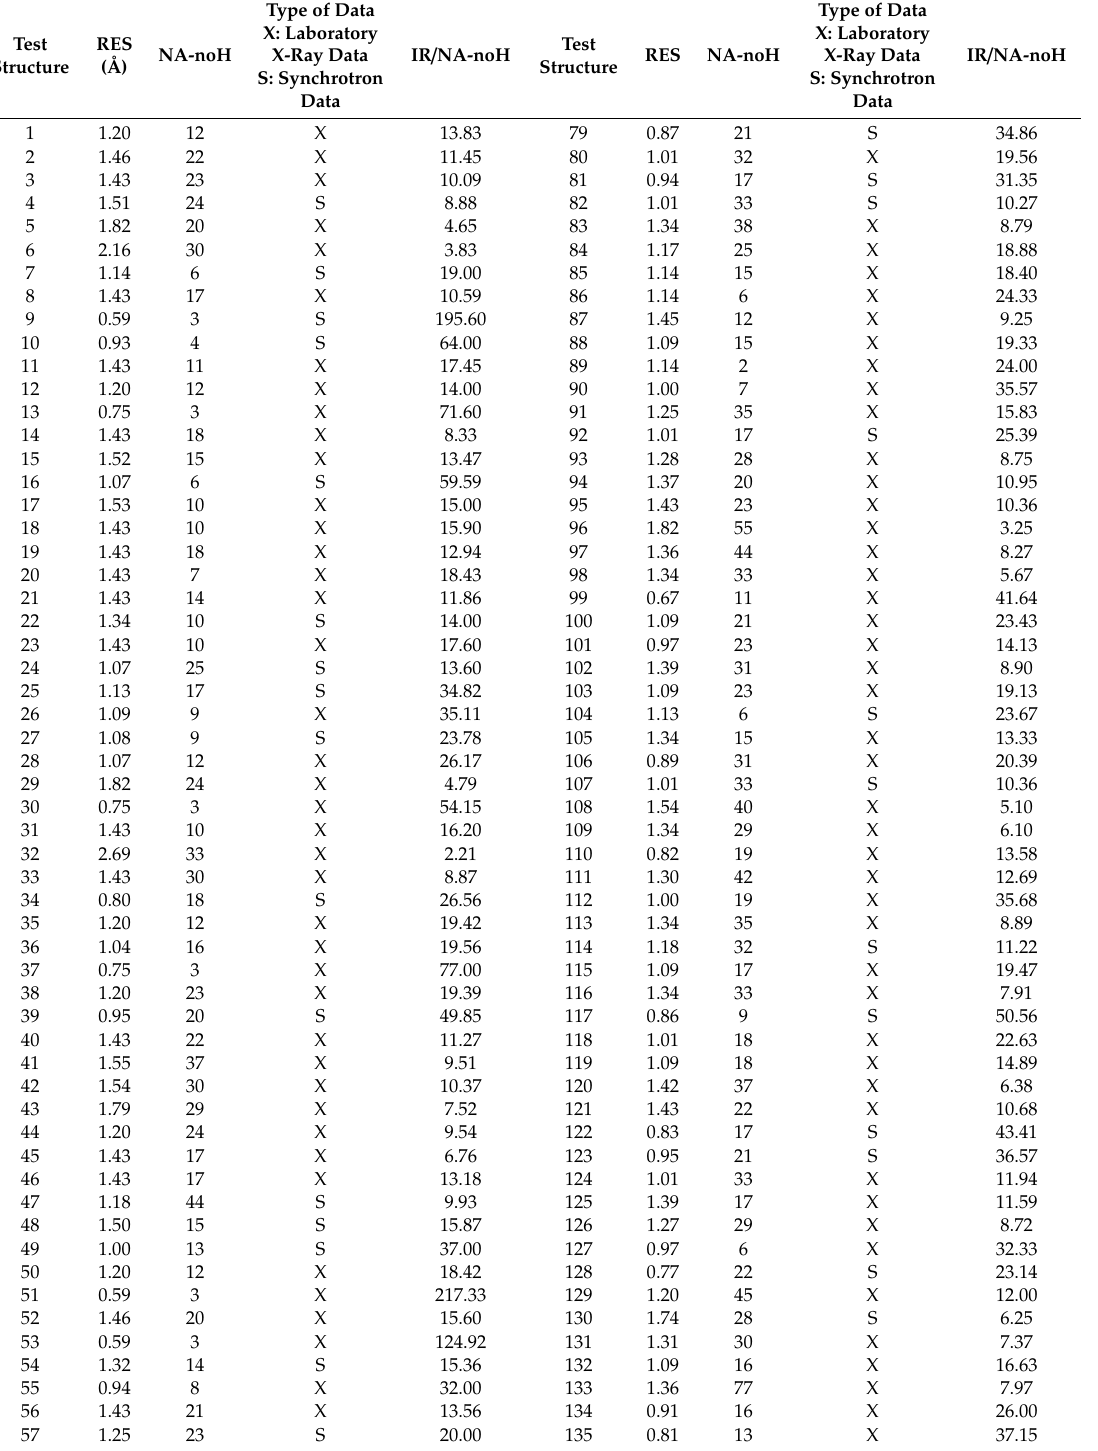
Table 1. For each of the 155 test structures, experimental resolution (RES); number of non-hydrogen atoms in the asymmetric unit (NA-noH); type of data (laboratory X-ray or synchrotron data); ratio of the number of independent reflections (IR) and NA-noH (IR /